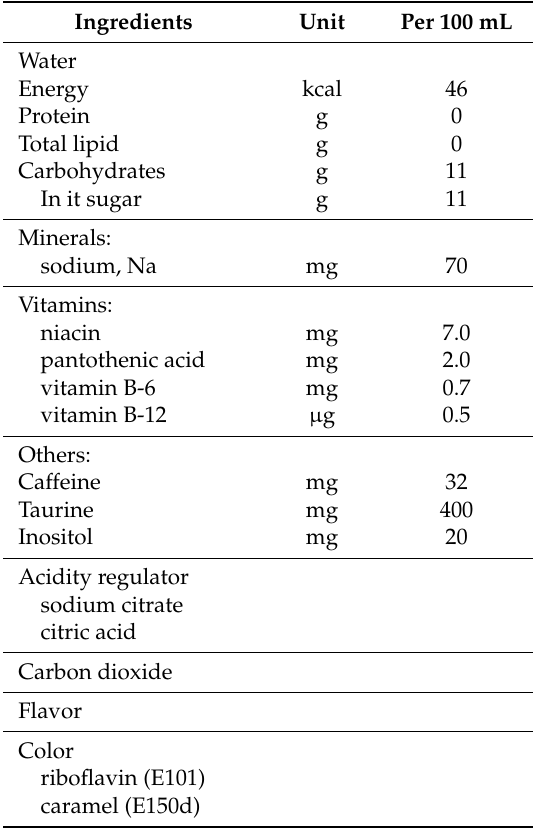
Table 1. Composition details of consumed energy